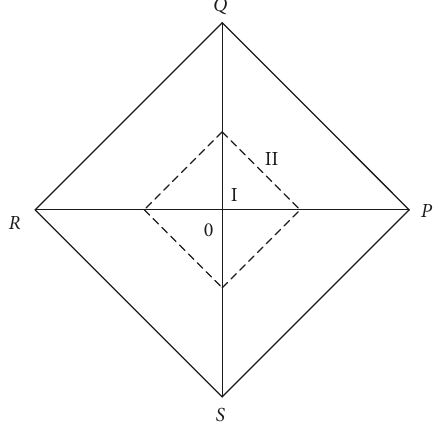
Figure 7: Two different plastic format areas of the